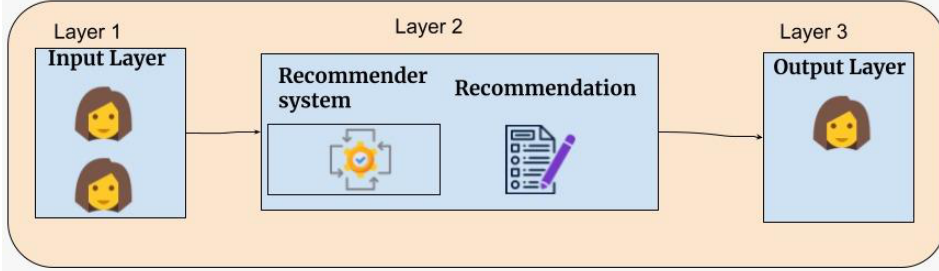
Figure 1. General view of the recommendation system.